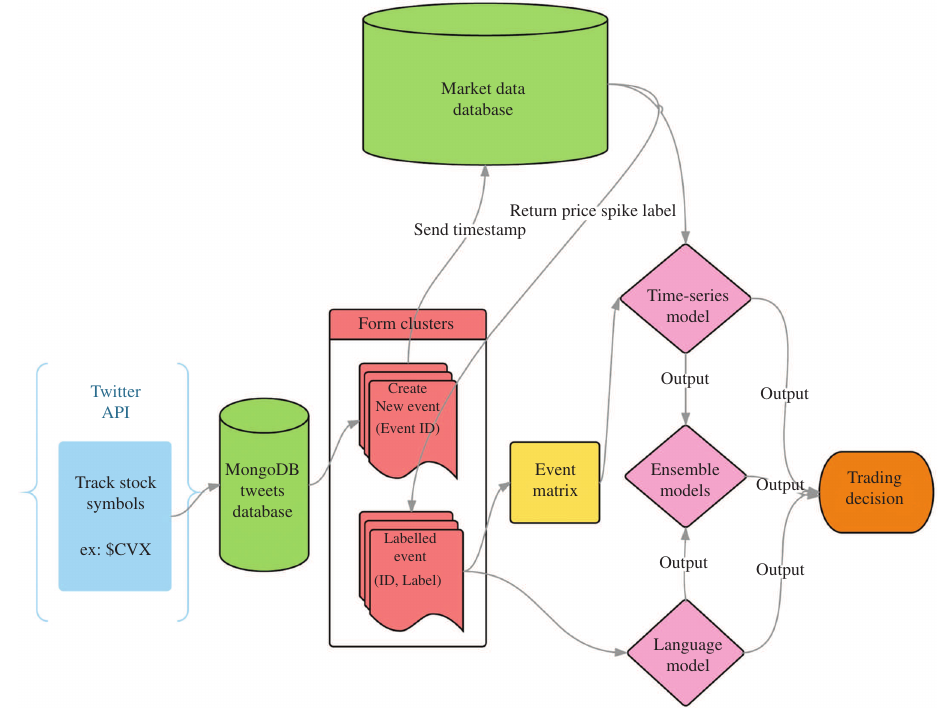
Figure 2: Flow Chart of System